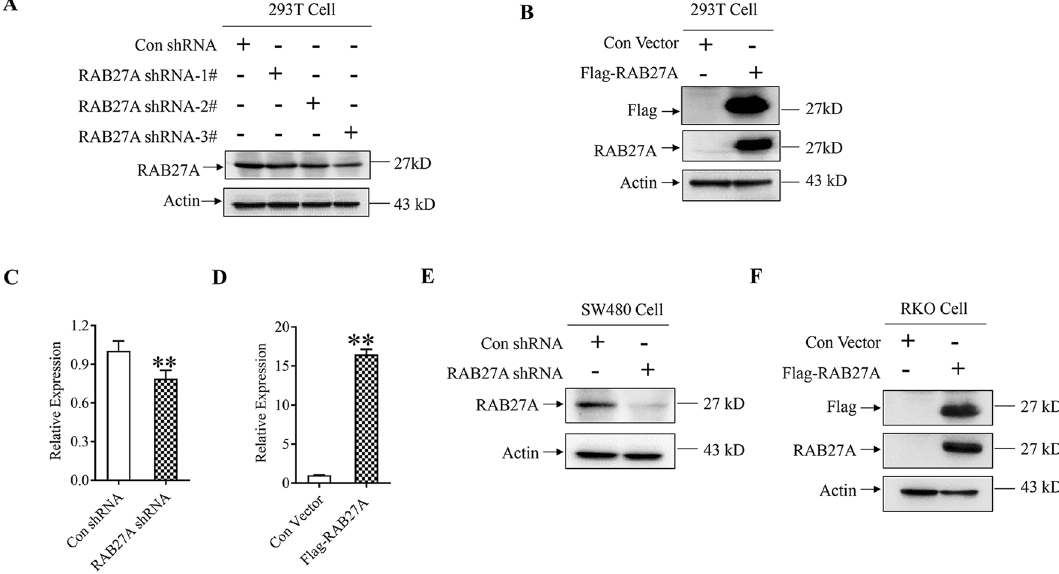
Figure 1. Identification of RAB27A knockdown and ectopic expression. ( A ) and ( B ). RAB27A knockdown and overexpression in 293 T cells. Cells were transfected with RAB27A shRNA and Flag-tag RAB27A plasmids, respectively. Then, western blotting was used to determine the expression level of RAB27A and Flag-tag RAB27A. Actin was used as a loading control. ( C ), ( D ), ( E ) and ( F ). Identification of RAB27A knockdown or overexpression in colon cancer cells. SW480 cells were transfected with RAB27A shRNA or Con shRNA plasmid, and RKO cells were transfected with Flag-tag RAB27A or the negative control plasmid. G418 (800 µg/ ml) was used to select cell clones stably expressing neo gene. The mRNA level of RAB27A was measured by using real time PCR, and the protein level of RAB27A was determined by western blot. Actin was used as a loading control. The level of RAB27A mRNA was normalized by comparing mRNA level in all groups with that in the negative control groups. The relative expression level of RAB27A mRNA was shown as mean ± S.D. and was analyzed by two-tailed t-test. All the experiments were repeated three times independently, and the representative results were shown. ** P < 0.01